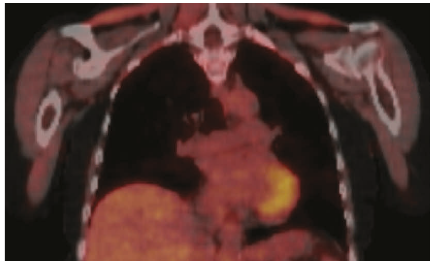
Figure 1: Initial positron emission tomography scan showing aortitis. Increased metabolic activity of the wall of the transverse aortic arch (arrow) and surrounding inflammation were suggestive of aortitis. Imaging was otherwise notable for a complete response with no evidence of metastatic disease.